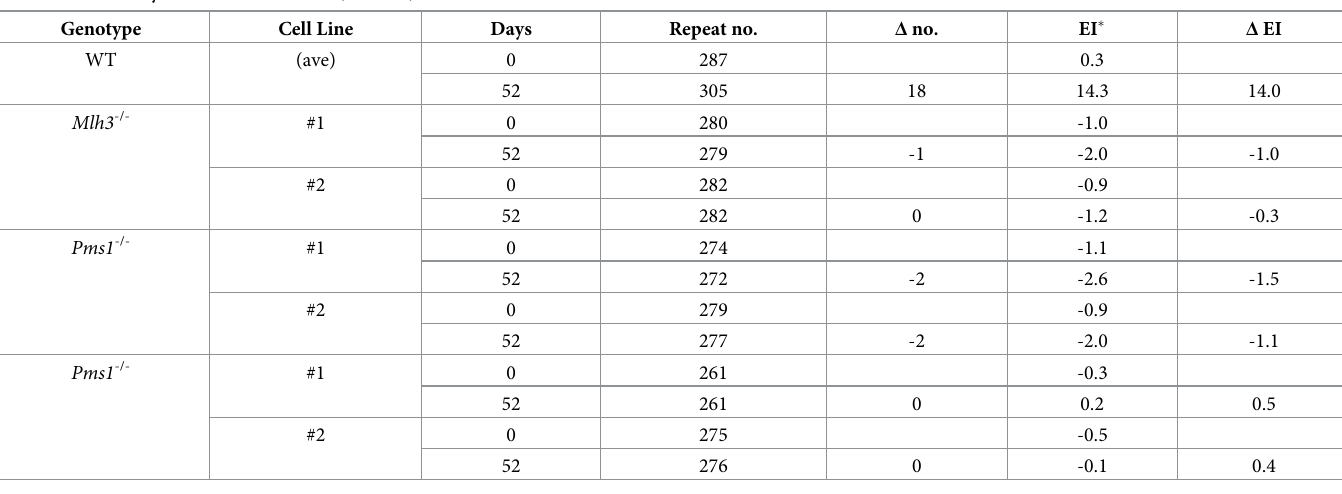
Table 1. Instability characteristics of WT, Mlh3 -/- , Pms 1 -/- and Pms 2 -/- mESCs.